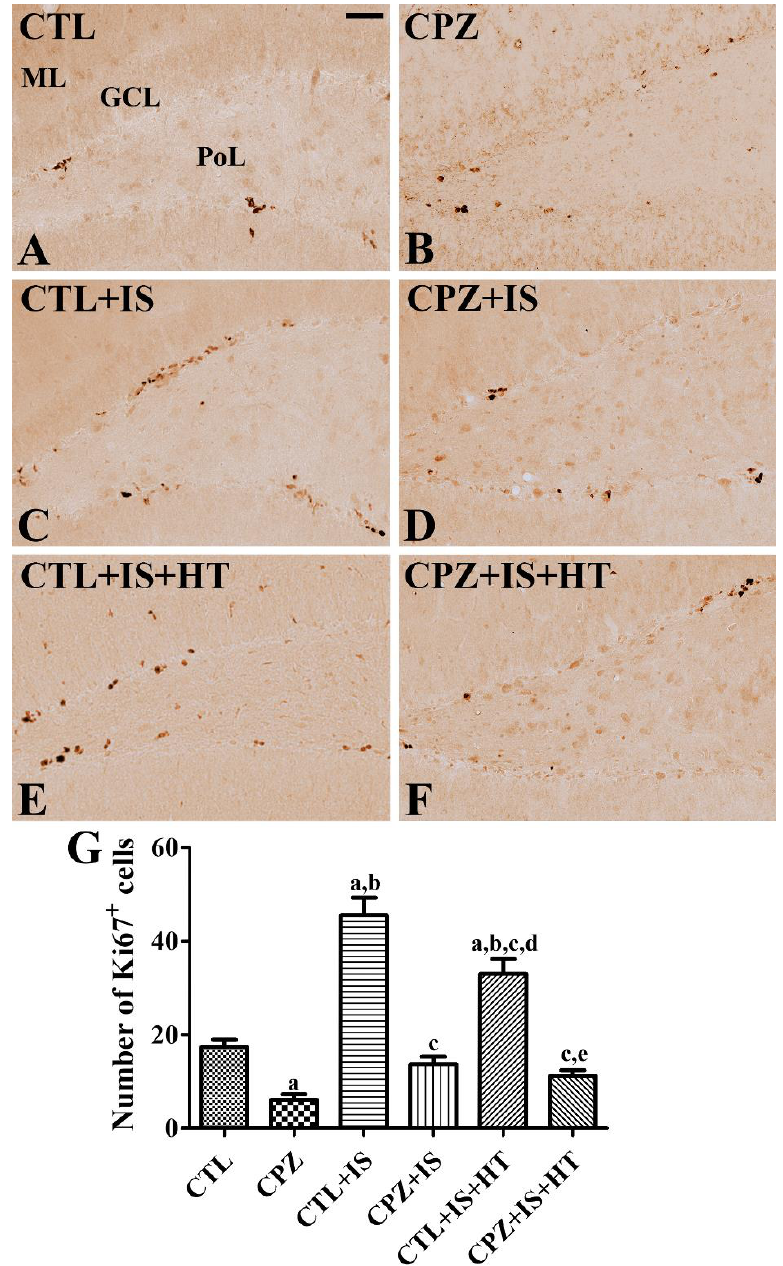
Figure 9. Ki67 immunohistochemistry in the gerbil hippocampal dentate gyrus of the CTL ( A ), CPZ ( B ), CTL + IS ( C ), CPZ + IS ( D ), CTL + IS + HT ( E ), and CPZ + IS + HT ( F ) groups. Ki67-positive nuclei were observed in the subgranular zone of the dentate gyrus. Ki67-positive nuclei were most abundant in the CTL + IS group and fewest in the CPZ group. GCL, granule cell layer; ML, molecular layer; PoL, polymorphic layer. Scale bar = 50 μM. ( G ) The number of Ki67-positive nuclei per section in each group is shown ( n = 5 per group, a p < 0.05, significantly different from the CTL group; b p < 0.05, significantly different from the CPZ group; c p < 0.05, significantly different from the CTL + IS group; d p < 0.05, significantly different from the CPZ + IS group; e p < 0.05, significantly different from the CTL + IS + HT group). Error bars indicate standard deviation.